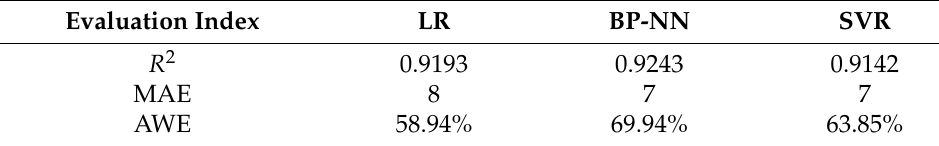
Table 3. Training results of different machine learning regression